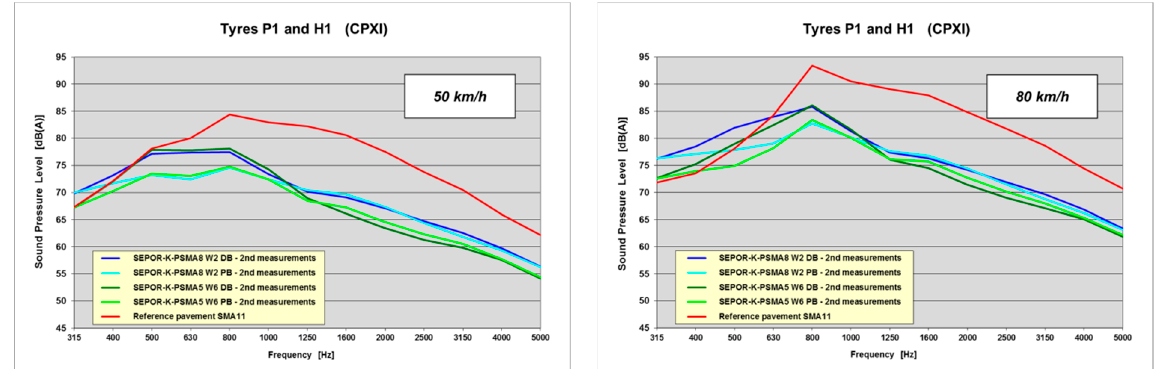
Figure 26. Frequency spectra of poroelastic wearing courses on the Kartoszyno long test section.